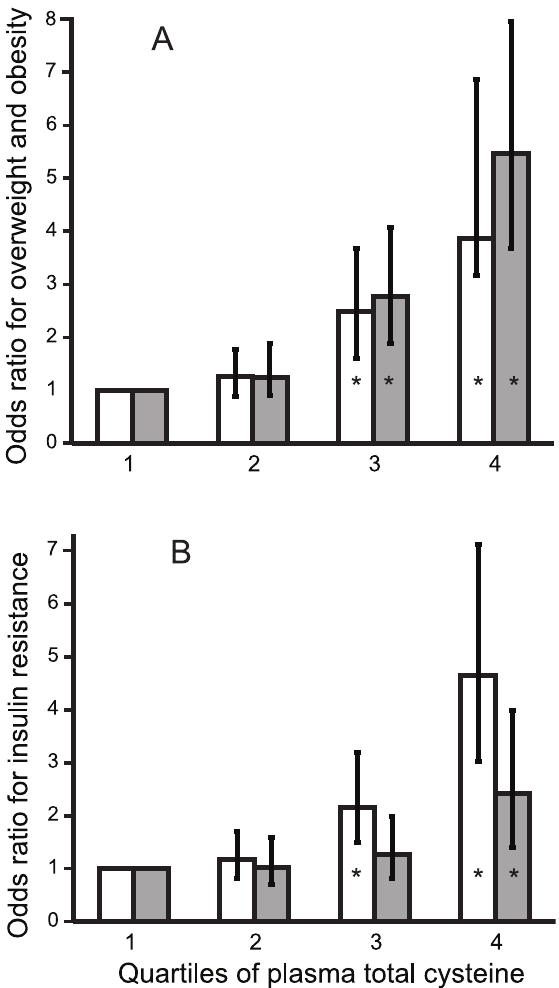
Figure 3. Odds ratios for overweight, obesity and insulin resistance according to plasma total cysteine. A: Age and gender- adjusted odds ratios and 95% confidence intervals for overweight (white bars) and obesity (grey bars) according to quartiles of plasma total cysteine (tCys). B: Age and gender-adjusted odds ratios for insulin resistance (defined as HOMA-IR index . 3.16) by quartiles of plasma tCys, with (grey bars) and without (white bars) adjustment for body fat%. * P # 0.001.